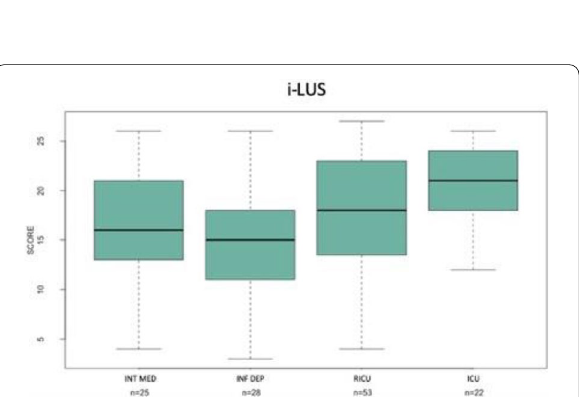
Fig. 5 Boxplots—i-LUS and hospitalization areas: INT MED Internal Medicine, INF DEP Infectious Diseases Department, RICU